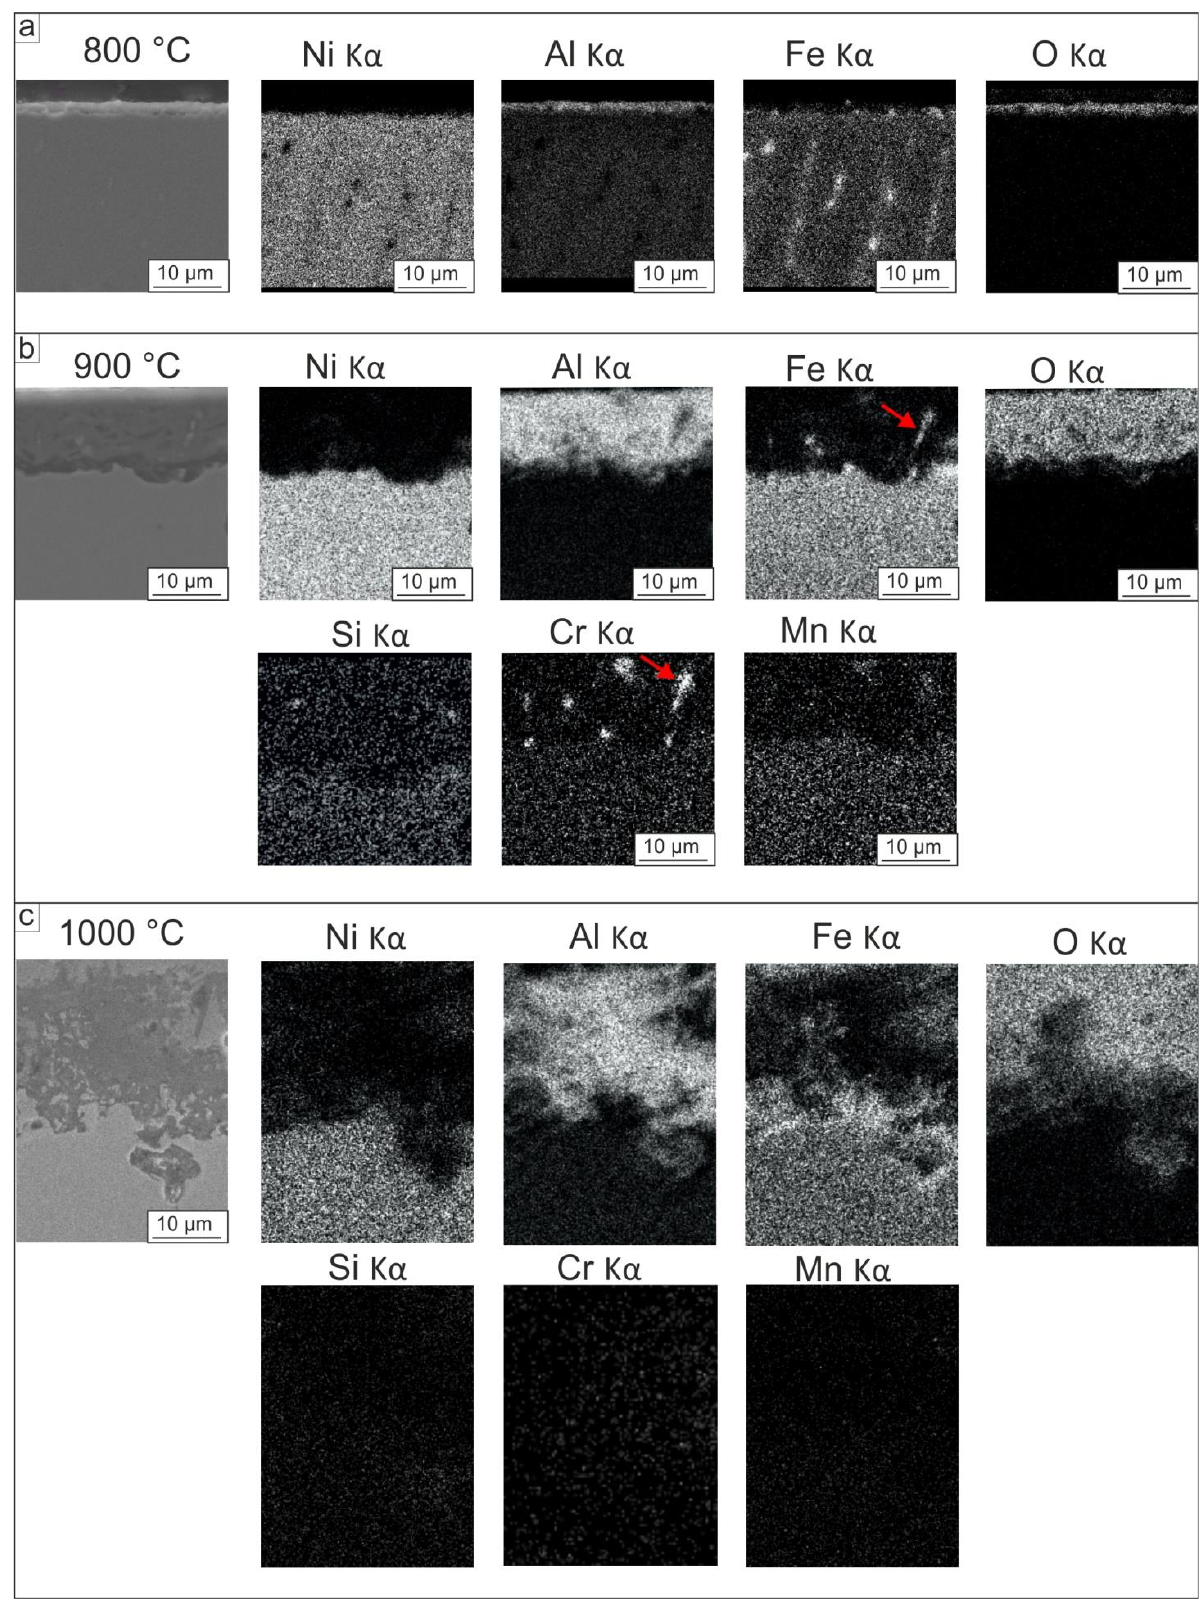
Figure 11. EDX analysis of the oxide film of NiAl-based coating in cross-sections after oxidation for 100 h at ( a ) 800; ( b ) 900; ( c ) 1000 °C. SEM images (left pictures), and corresponding EDX maps.